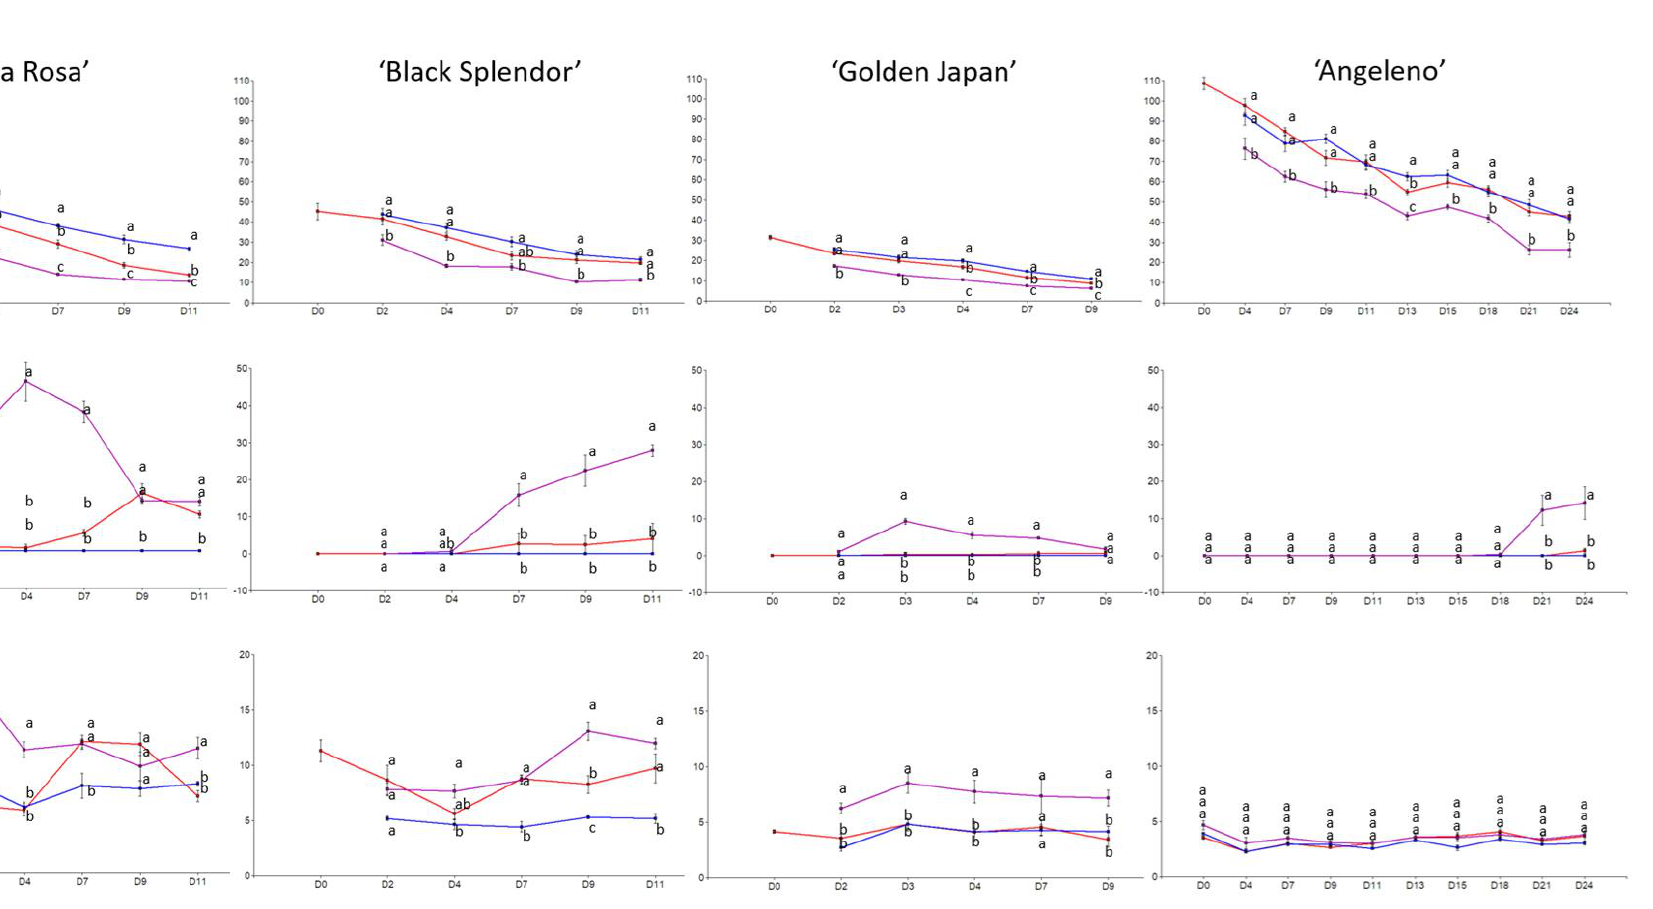
Figure 2. Evolution of fruit firmness by compression (N), ethylene emission (mg kg −1 h −1 ) and CO 2 emission (g kg −1 h −1 ) of Japanese plum cultivars assayed during the shelf-life period at 20 °C for control (red color), 1-MCP (blue color), and Ethrel treatments (purple color). Letters show significant differences in the Tukey test ( p -value < 0.05).